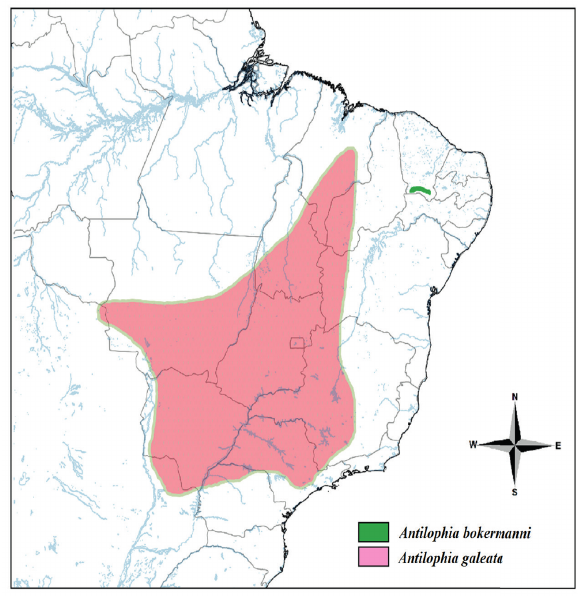
Figure 2 - Geographic distribution of A. bokermanni and A. galeata . The geographic ranges of the two species were adapted from